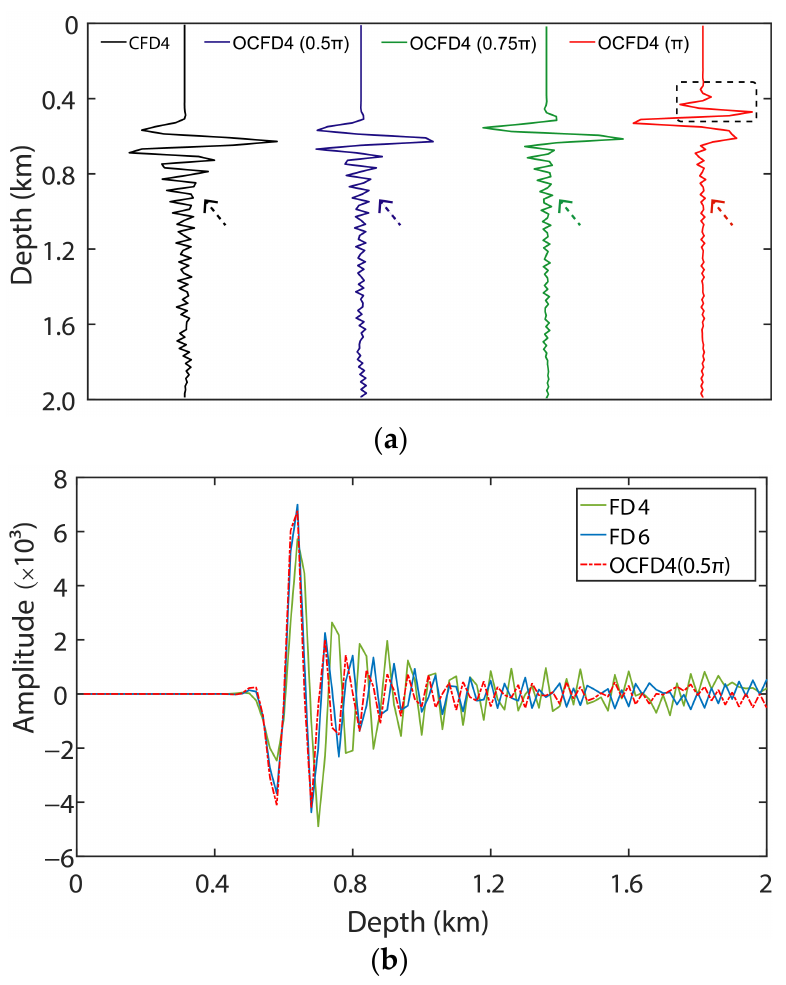
Figure 5. Single traces of the snapshots at lateral distance of 2 km. ( a ) Comparison of the CFD4 and